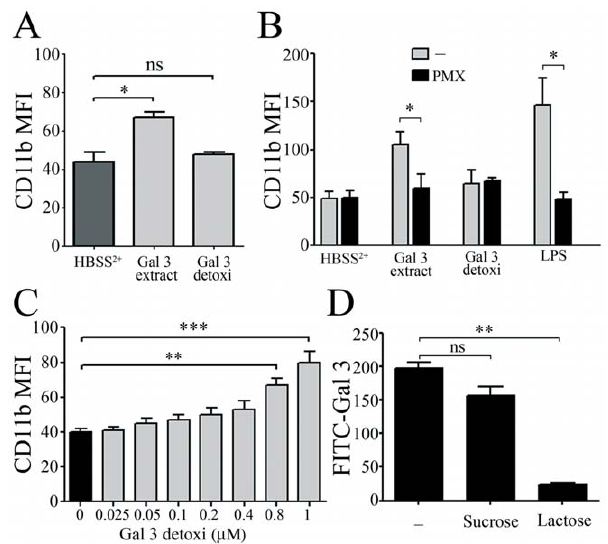
Figure 1. Contaminating LPS interferes with the ability of Gal 3 to activate neutrophils. Freshly isolated neutrophils (2.0 6 10 6 /ml) were incubated for 45 min at 37 u C in HBSS 2 + in the presence of: A : Recombinant Gal 3 preparation (0.2 m M), which had been depleted of endotoxin (detoxi) or not (extract), by absorption on detoxigel (n=3). B : 0.2 m M of extract or endotoxin-depleted recombinant Gal 3, which had been preincubated for 30 min at 37 u C with polymyxin B (PMX, 40 mg/ ml) (n=3). C : Increasing molar concentrations of endotoxin-depleted Gal 3 (n=3). After staining with a specific anti-CD11b mAb, cells were analyzed by flow cytometry. D : Non-stimulated PMN (2.0 6 10 6 /mL) were incubated with FITC-labeled Gal 3 (0.2 m M) for 30 min at 4 u C, in the presence or absence of 20 mM sucrose or lactose. The binding of FITC- Gal 3 to neutrophils was analyzed by flow cytometry (n=3). Results are expressed as mean fluorescence intensity (MFI). * p , 0.05; **p , 0.01; ***p , 0.001.